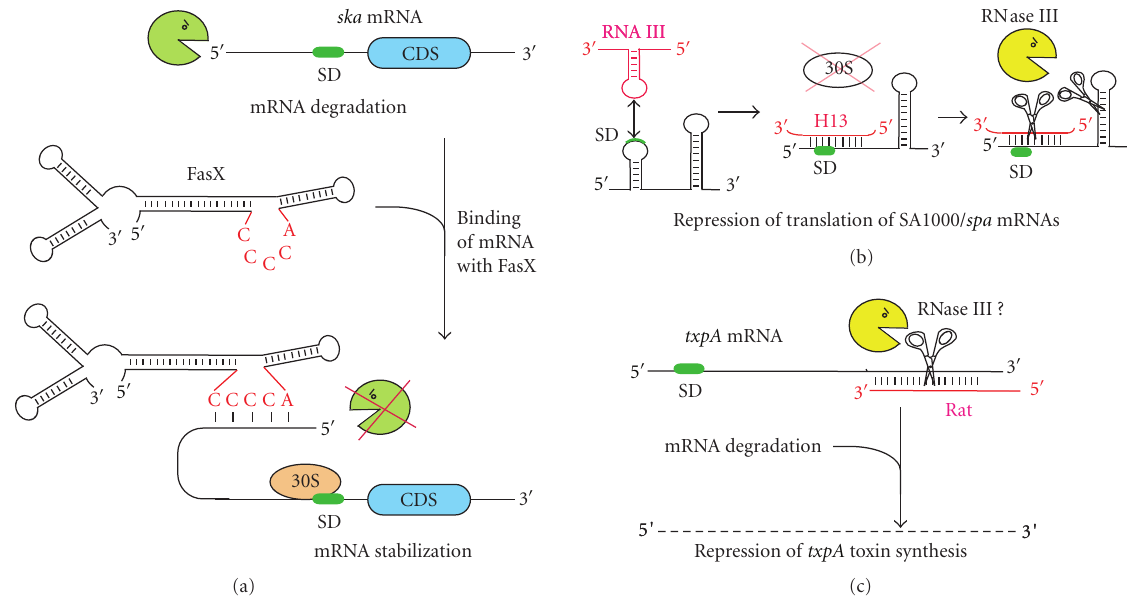
Figure 2: Diagram illustrating di ff erent mechanisms of posttranscriptional regulation. (a) Stabilization of S. pyogenes ska mRNA. Transcript levels of ska are regulated by RNase-mediated decay. Under stress conditions, the FasX sRNA is expressed and binds to the 5 (cid:2) leader region of ska mRNA inhibiting RNase degradation [70]. (b) S. aureus RNAIII/RNase III repression of translation. The quorum-sensing regulatory RNAIII uses a regulatory hairpin to bind to spa mRNA (or SA1000) target sequence. The initial loop-loop interaction is converted to a duplex sequestering the Shine-Dalgarno sequence (SD). Access of the ribosome is blocked and translation is repressed. RNase III is recruited to the hybrid region and to an additional hairpin present in spa and cleaves the transcript making the regulatory event irreversible [71, 72]. (c) Repression of B. subtilis TxpA toxin synthesis. The asRNA Rat is transcribed convergently and is fully complementary to the txpA mRNA. Binding of Rat asRNA to txpA transcript induces rapid degradation of the mRNA [73]. The RNase performing the initial cleavage might be RNase III although the nature of the enzyme and the structure of the hybrid are not yet